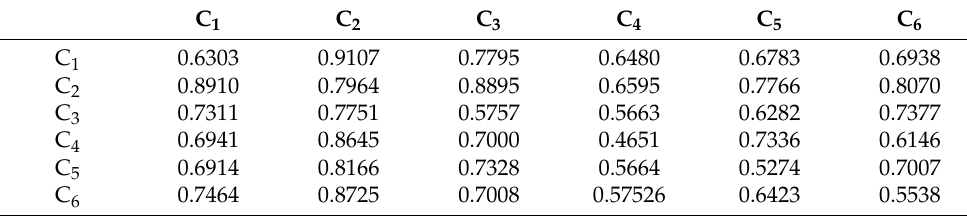
Table 7. Transpose matrix of comprehensive influence matrix of first-level influencing factors.